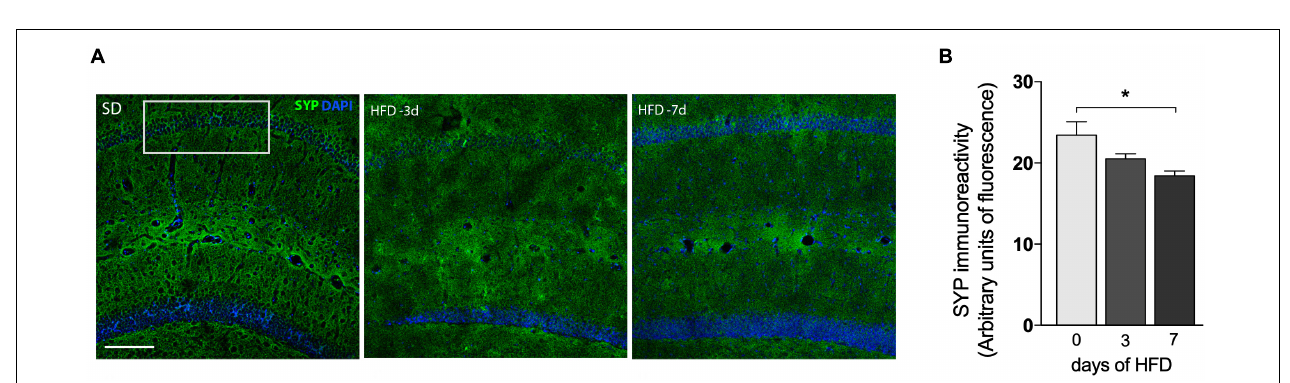
FIGURE 3 | Evaluation of the high-fat diet effects in an early time-course. Assessment of the onset changes in (A) cognition ( n = 6–8/group; one-sample t -test with hypothetical value of 50%), (B) depressive-like behavior ( n = 6–8), (C) BBB leakage in hippocampus of mice fed HFD from 1 up to 6 days ( n = 4), as well as proinflammatory cytokines represented by (D) TNF- α , (E) IL-6, and (F) IL-1 β ( n = 4). One-way ANOVA followed by Dunnett post hoc test performed for (B–F) . * p < 0.05, *** p < 0.001 SD vs. HFD. Values are mean ± SEM. + p < 0.05 vs. chance levels (50% of a new object investigation in test trial).